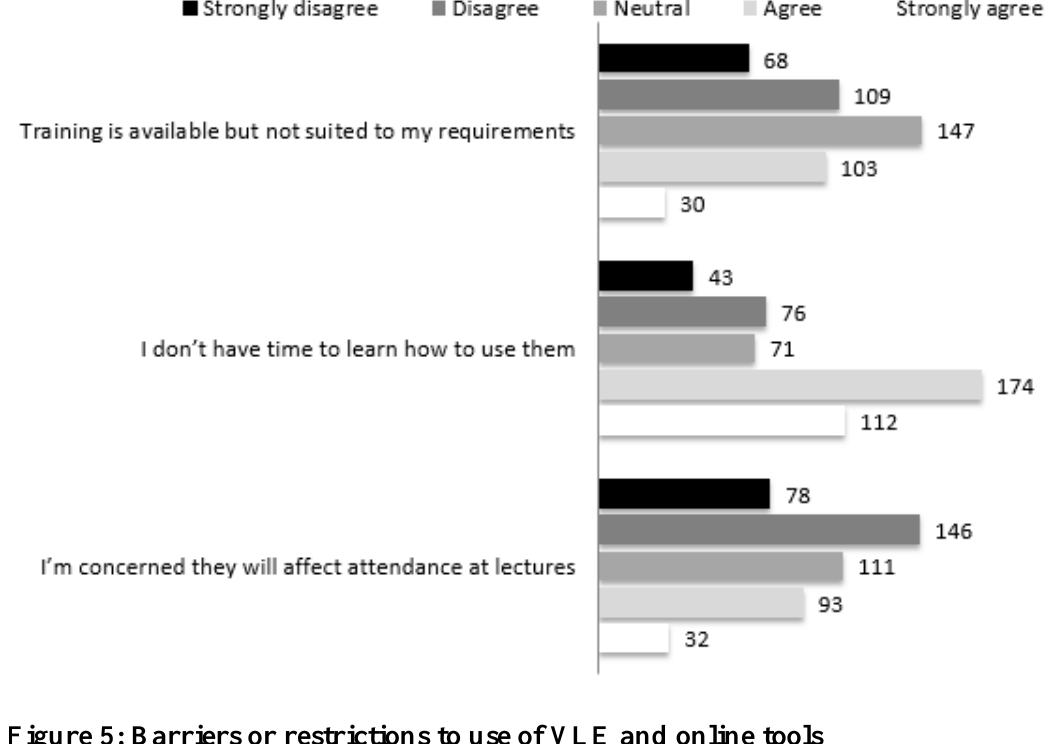
Figure 5: Barriers or restrictions to use of VLE and online tools